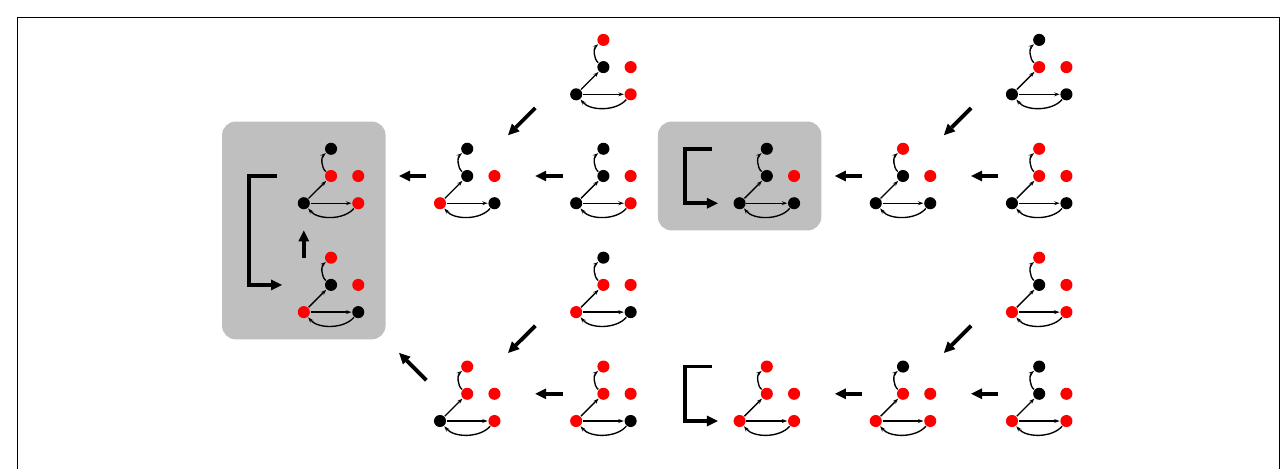
ends up on one of the attractors (shaded rectangles). For the 16 (of 2 5 ) states shown here, it can either be a 2-cycle or one of the two fixed